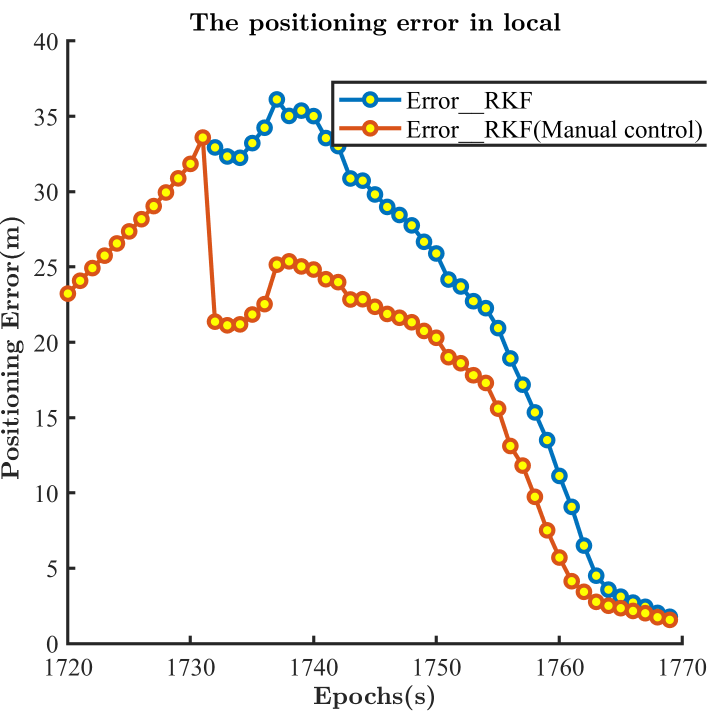
Figure 15. The comparison between the performances with and without the manual